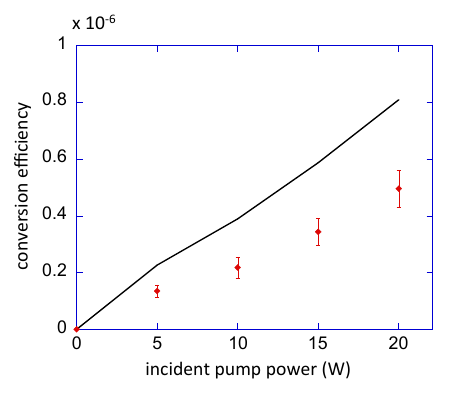
The conversion efficiency from the mixing beam to the 636 nm anti-Stokes sideband as the incident pump power is varied at a constant D pressure of 0.3 atm. The solid 2 line is a theoretical calculation without any adjustable parameters, based on the measured transmitted powers of the pump and the Stokes beams through the